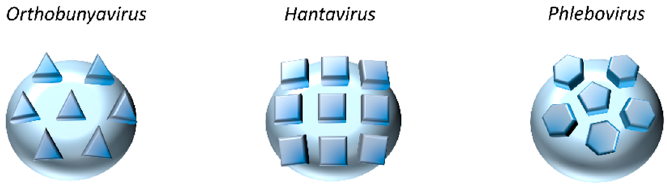
Figure 3. Schematic representation of the bunyavirus G N and G C glycoprotein arrangement on the surface of viral particles. The symmetries shown here were obtained by cryo ‐ electron tomography and image reconstruction from Bunyamwera virus ( Orthobunyavirus , left panel), Tula virus (TULV) and Hantaan virus (HTNV) ( Hantavirus , middle panel), as well as Rift Valley fever (RVFV) and Uukuniemi (UUKV) viruses ( Phlebovirus , right panel) [39 ‒ 45]. Images were adapted from [44].